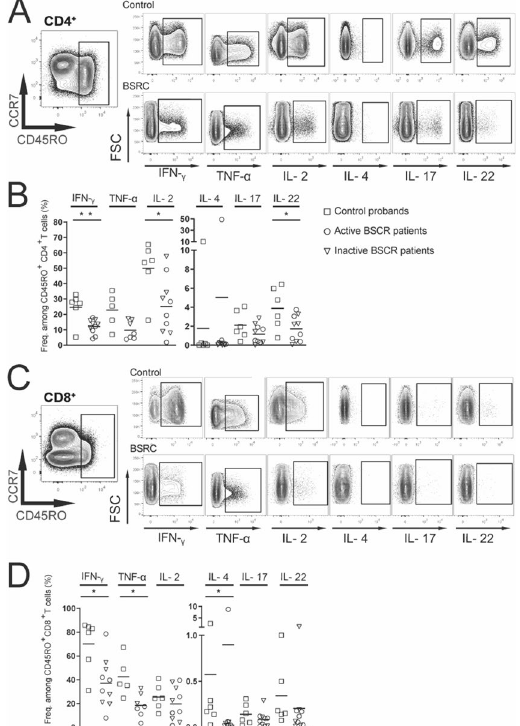
Figure 3. Reduced potential of BSRC memory T-cells to exert effector function. ( A ) Exemplary gating strategy of CD45RO + memory T-cells and exemplary gating strategy of different cytokines after 6 h polyclonal activation in CD4 + ( A ) and CD8 + ( C ) T cells in control probands (upper row) and patients (lower row) respectively. ( B , D ) Analysis of IFN-γ, TNF-α, IL-2, IL-4, IL-17, and IL-22-producing CD45RO + T-cell fractions in controls and BSCR patients. Lines indicate median. Mann Whitney U test was used for statistical analysis p < 0.05*. BSRC birdshot retinochoroiditis, IFN-γ interferon gamma, IL interleukin, TNF-α tumor necrosis factor